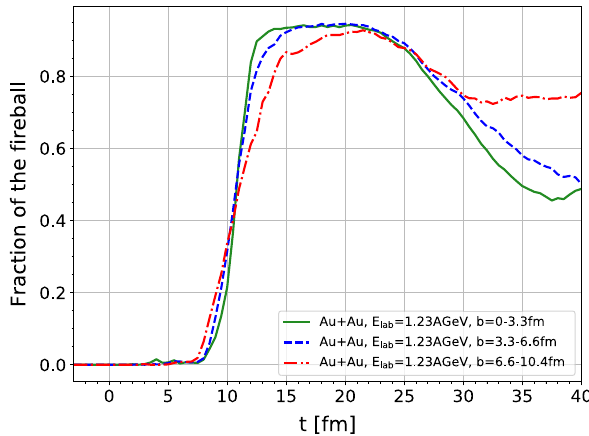
Fig. 17 Time evolution of the average fraction of the system satis- fying the conditions X < 0 . 3, Y < 0 . 3, ε > 1 MeV / fm 3 Au+Au at